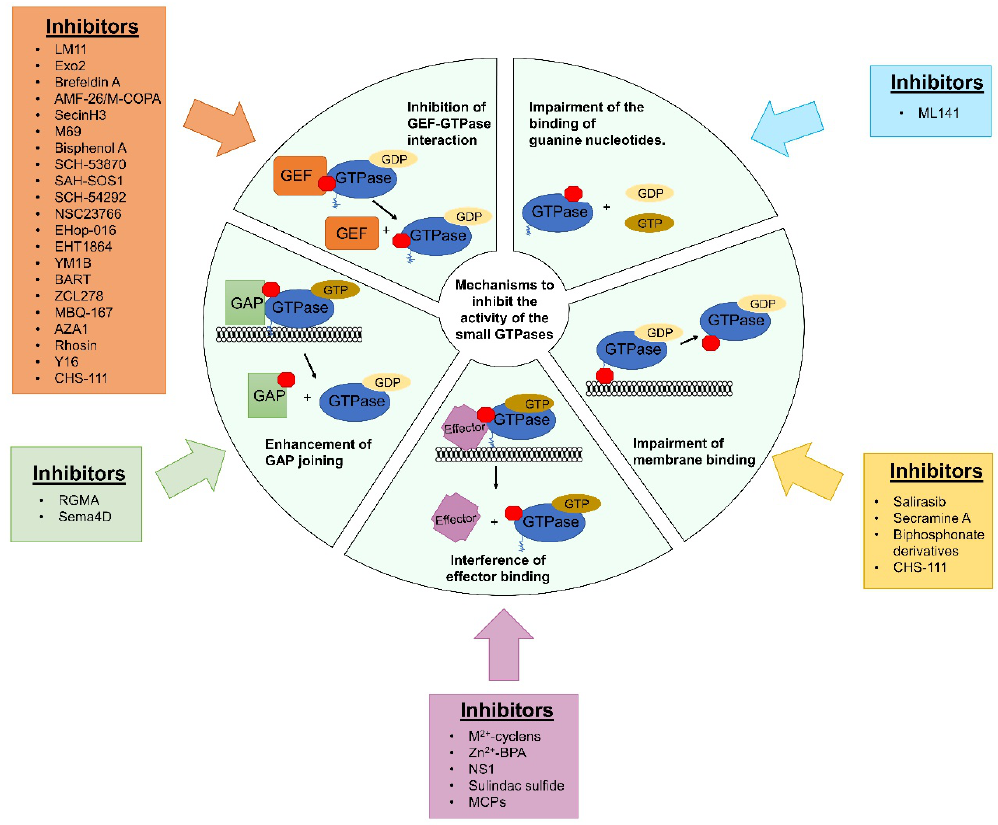
Figure 2. New strategies to target small GTPases in human cancers. To improve the therapeutic efficacy of inhibitors of small GTPases, new approaches have been developed by different strategies. Red boxes represent the inhibitor of GTPases in each of the strategies. Those include generation of new molecules that can fill the specific GEF binding site in GTPases, disruption of GEF-mediated guanine nucleotide exchange, filling of nucleotide binding pocket of small GTPases, impairing nucleotide attachment, and the stimulation of GAP proteins. Given that most of small GTPases need to be attached to the organelle membrane to exert their actions, the development of novel molecules with the ability to abolish this binding has arisen recently as an innovative strategy to inhibit these molecules. Finally, the development of some drugs that interfere with these could also be great to inhibit small GTPases. A brief table situated next to each section of the graphic indicates the small GTPase inhibitors that work through that